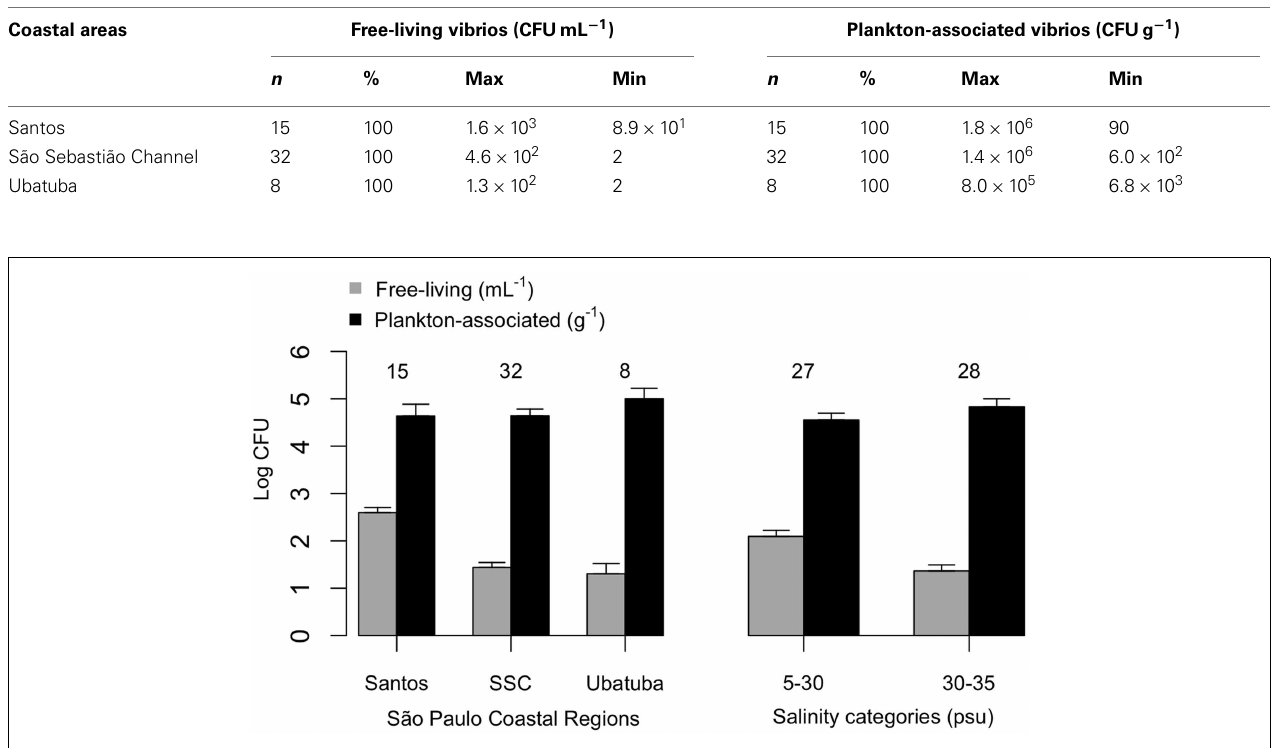
FIGURE 3 | Free-living (CFUmL − 1 ) and plankton-associated (CFUg − 1 ) vibrio concentration from São Paulo coastal areas. Data shown by coastal site (left panel) and salinity categories (right panel). Number of samples analyzed are indicated on top of standard error bars. CFU, colony-forming units.